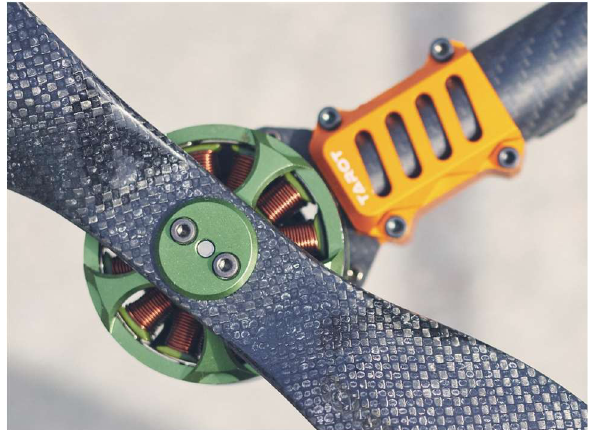
Figure 3. Multistar Elite 5008-330 fitted with a 18” 5.5” pitch propeller and attached to a Tarot T960 hexacopter frame.